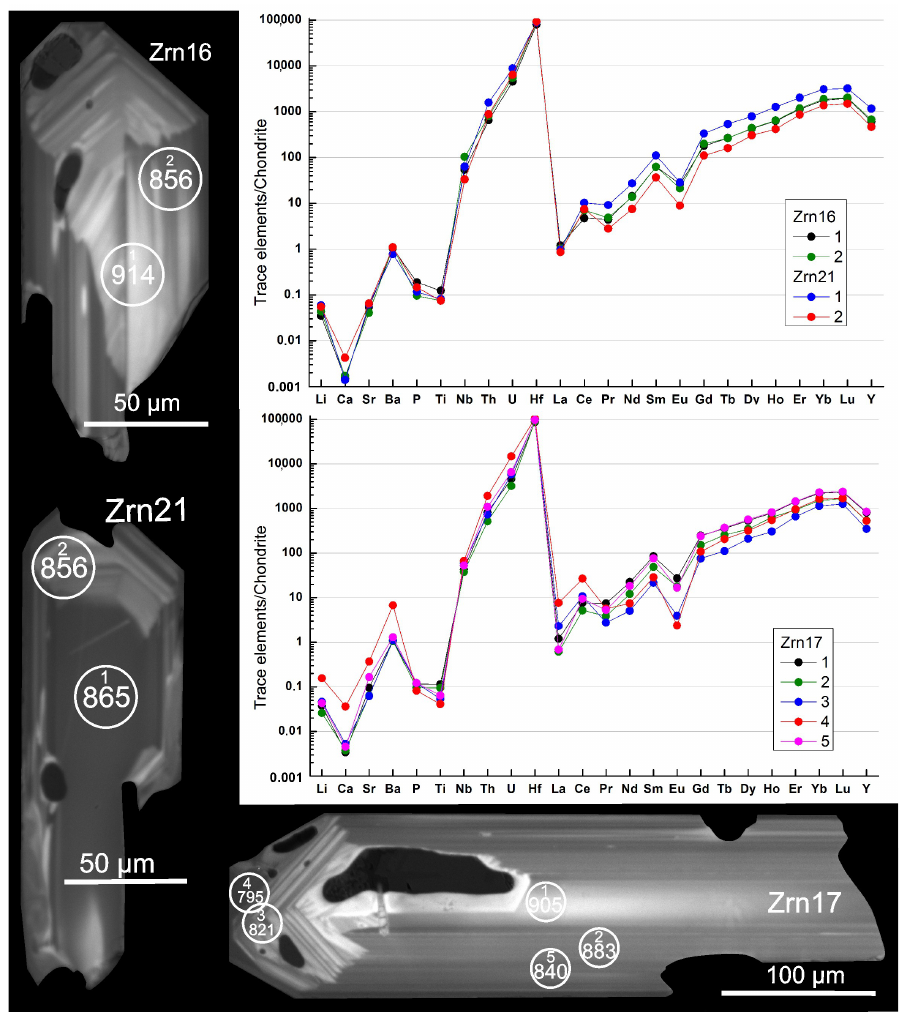
Figure 17. The legend is the same as that presented in Figure 16. Various types of internal zonality are observed in zircon grains during monochromatic